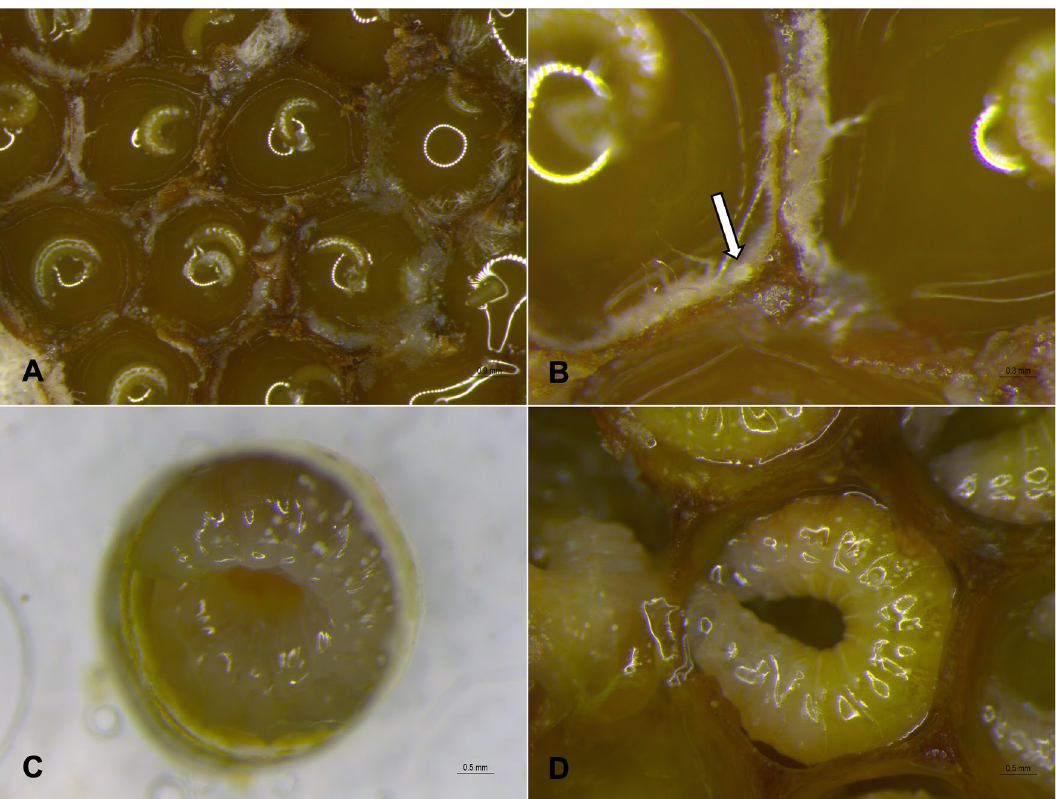
Figure 1. Scaptotrigona postica and its beneficial mites. ( a ) Brood cells in the brood combs of S. postica , ( b ) Newly-uncapped brood cell: P. ( N .) alvearii (indicated by the arrow) feeding on the fungi inside S. postica brood cells, ( c ) S. postica larvae completely fed in the in vitro rearing plates, with mites no longer seen, and ( d ) S. postica larvae completely fed in the natural system, with mites no longer